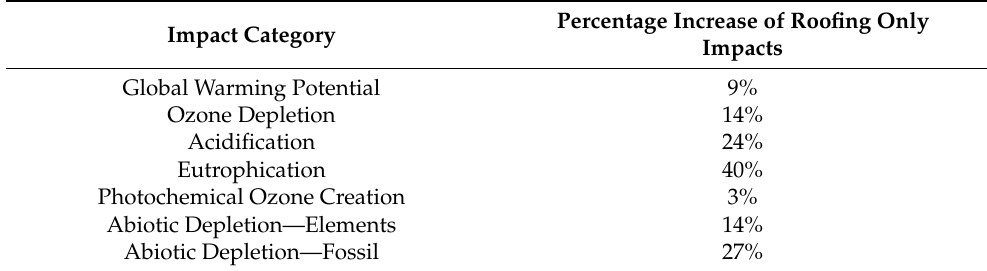
Table 4. Recommended percentage increase in environmental impacts from roofing only to include ancillary